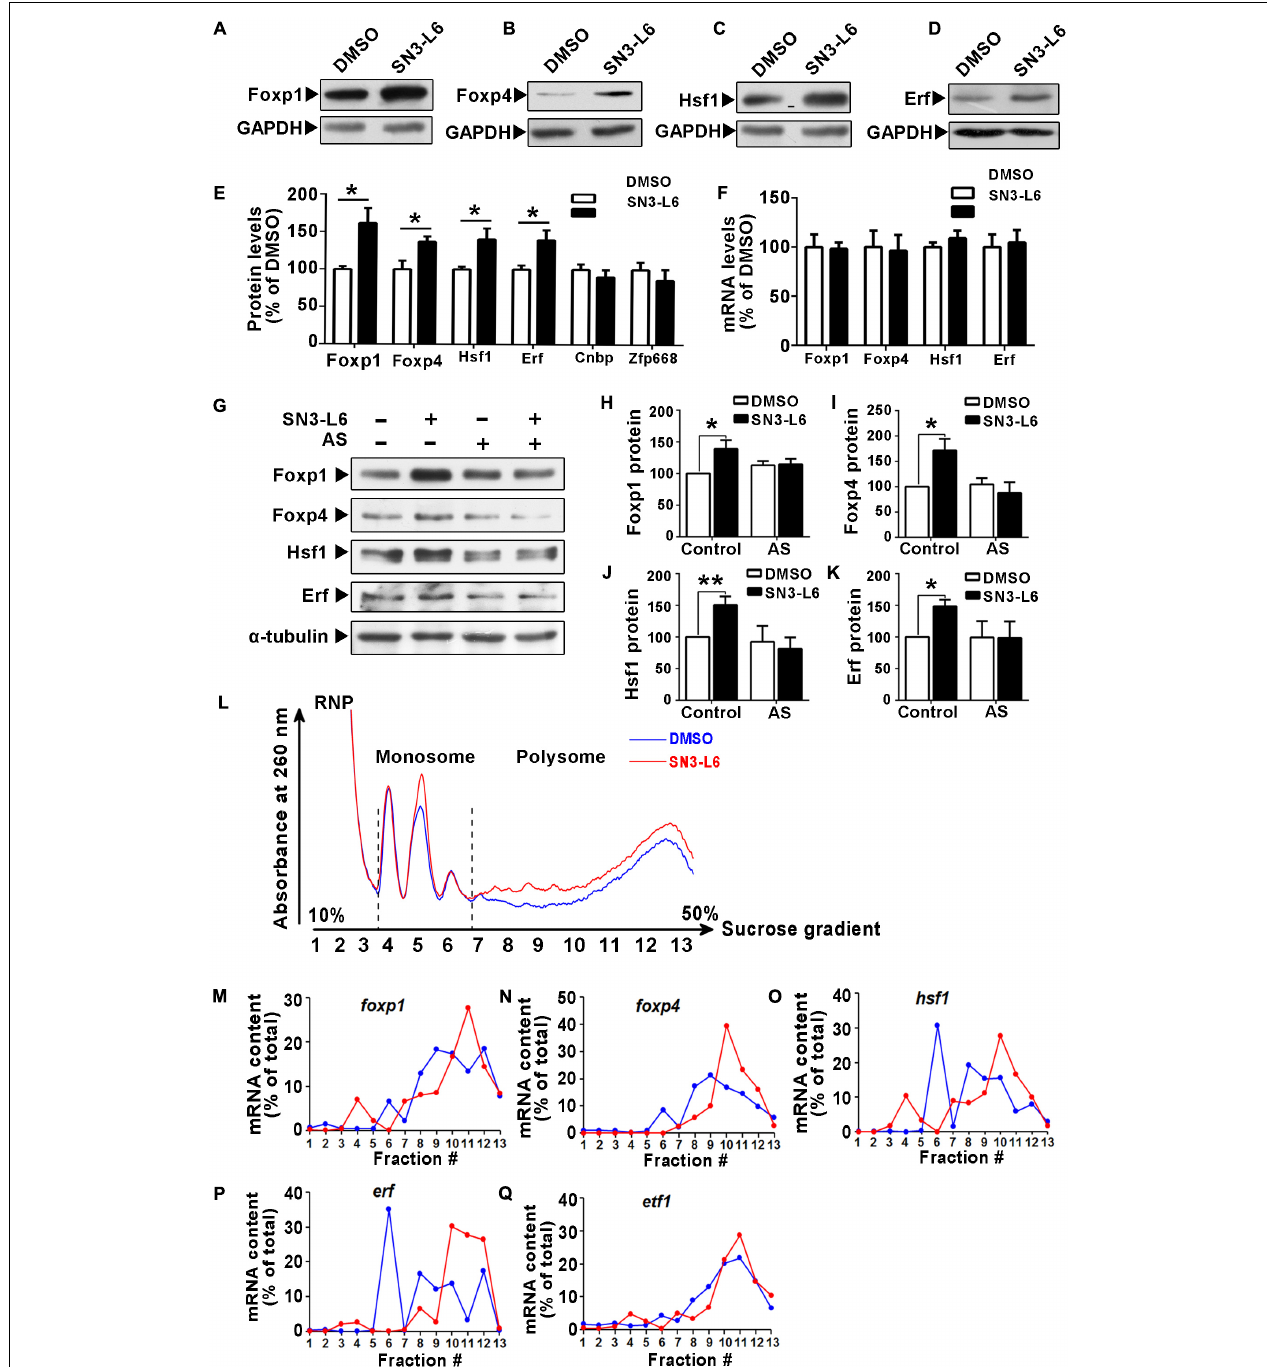
FIGURE 6 | SN3-L6 translationally upregulates Foxp1, Foxp4, Hsf1, and Erf. Western blot analysis shows that SN3-L6 (25 µ M) increased protein expressions of transcription factors Foxp1 (A) , Foxp4 (B) , Hsf1 (C) , and Erf (D) . GAPDH was used as a loading control. (E) Statistical analysis of the protein level changes of Foxp1, Foxp4, Hsf1, and Erf. Error bars represent SEM from three independent experiments, unpaired Student’s t -test; ∗ P < 0.05. (F) SN3-L6 did not affect mRNA transcript levels of Foxp1, Foxp4, Hsf1, and Erf as revealed by representative RT-qPCR results. Data are normalized by GAPDH mRNA levels and are presented as mean ± SEM from four independent experiments, unpaired Student’s t -test. (G) Western blot analysis showing that the translation inhibitor AS (0.5 µ M) blocked SN3-L6-induced upregulation of Foxp1, Foxp4, Hsf1, and Erf. α -tubulin was used as a loading control. (H–K) Quantification of protein levels. Data are presented as mean ± SEM from four independent experiments. ∗ P < 0.05, ∗∗ P < 0.01, SN3-L6 vs. DMSO, unpaired Student’s t -test in group. (L) Polysome profiles from Neuro-2a cells show that SN3-L6 treatment for 2 h increased global translation. RT-qPCR analysis showing amounts of foxp1 (M) , foxp4 (N) , hsf1 (O) , erf (P) , and etf1 (gene of eRF; Q ) mRNAs in different fractions. RNP, ribonucleoprotein.